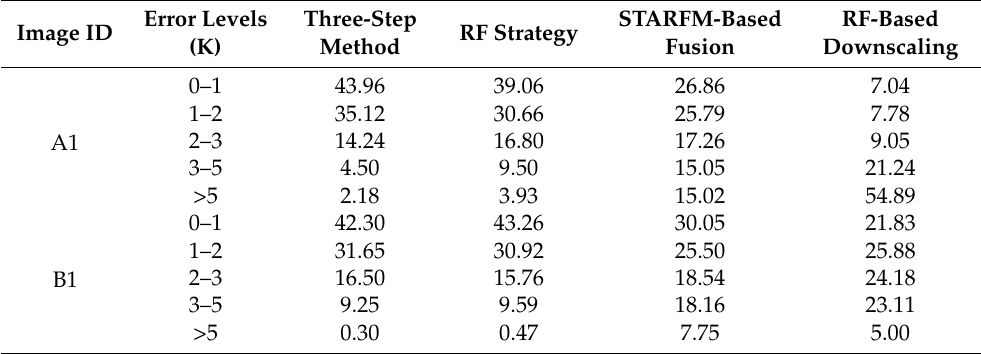
Table 3. Area percentage of distribution error for the four predicted LST images at five error levels in Images A1 and B1